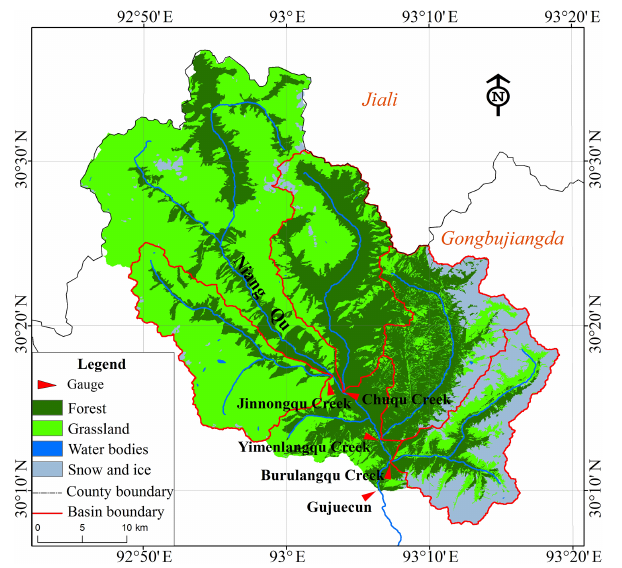
Figure 3. Map of the land-use distribution of gauges in the outlets of the